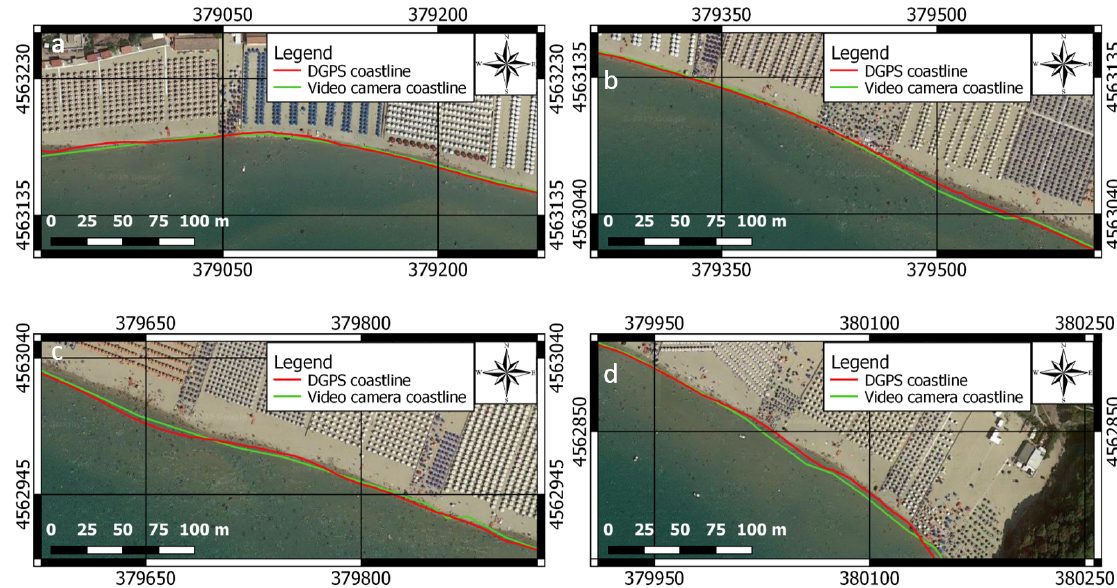
Figure 10. Video camera coastline (in green) compared with the DGPS coastline (in red) along Serapo beach. (basemap c (cid:13) 2018 Google product). In order to guarantee a better representation of the two coastlines, the beach has been divided into four sections, shown in the panels a – d , starting from west (panel a ) to east (panel d